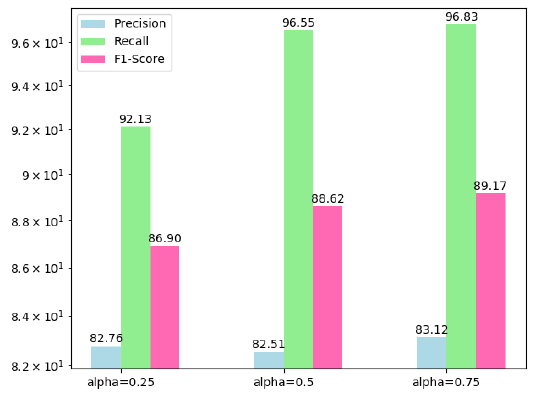
Figure 8. Quantitative comparison of α f for focal